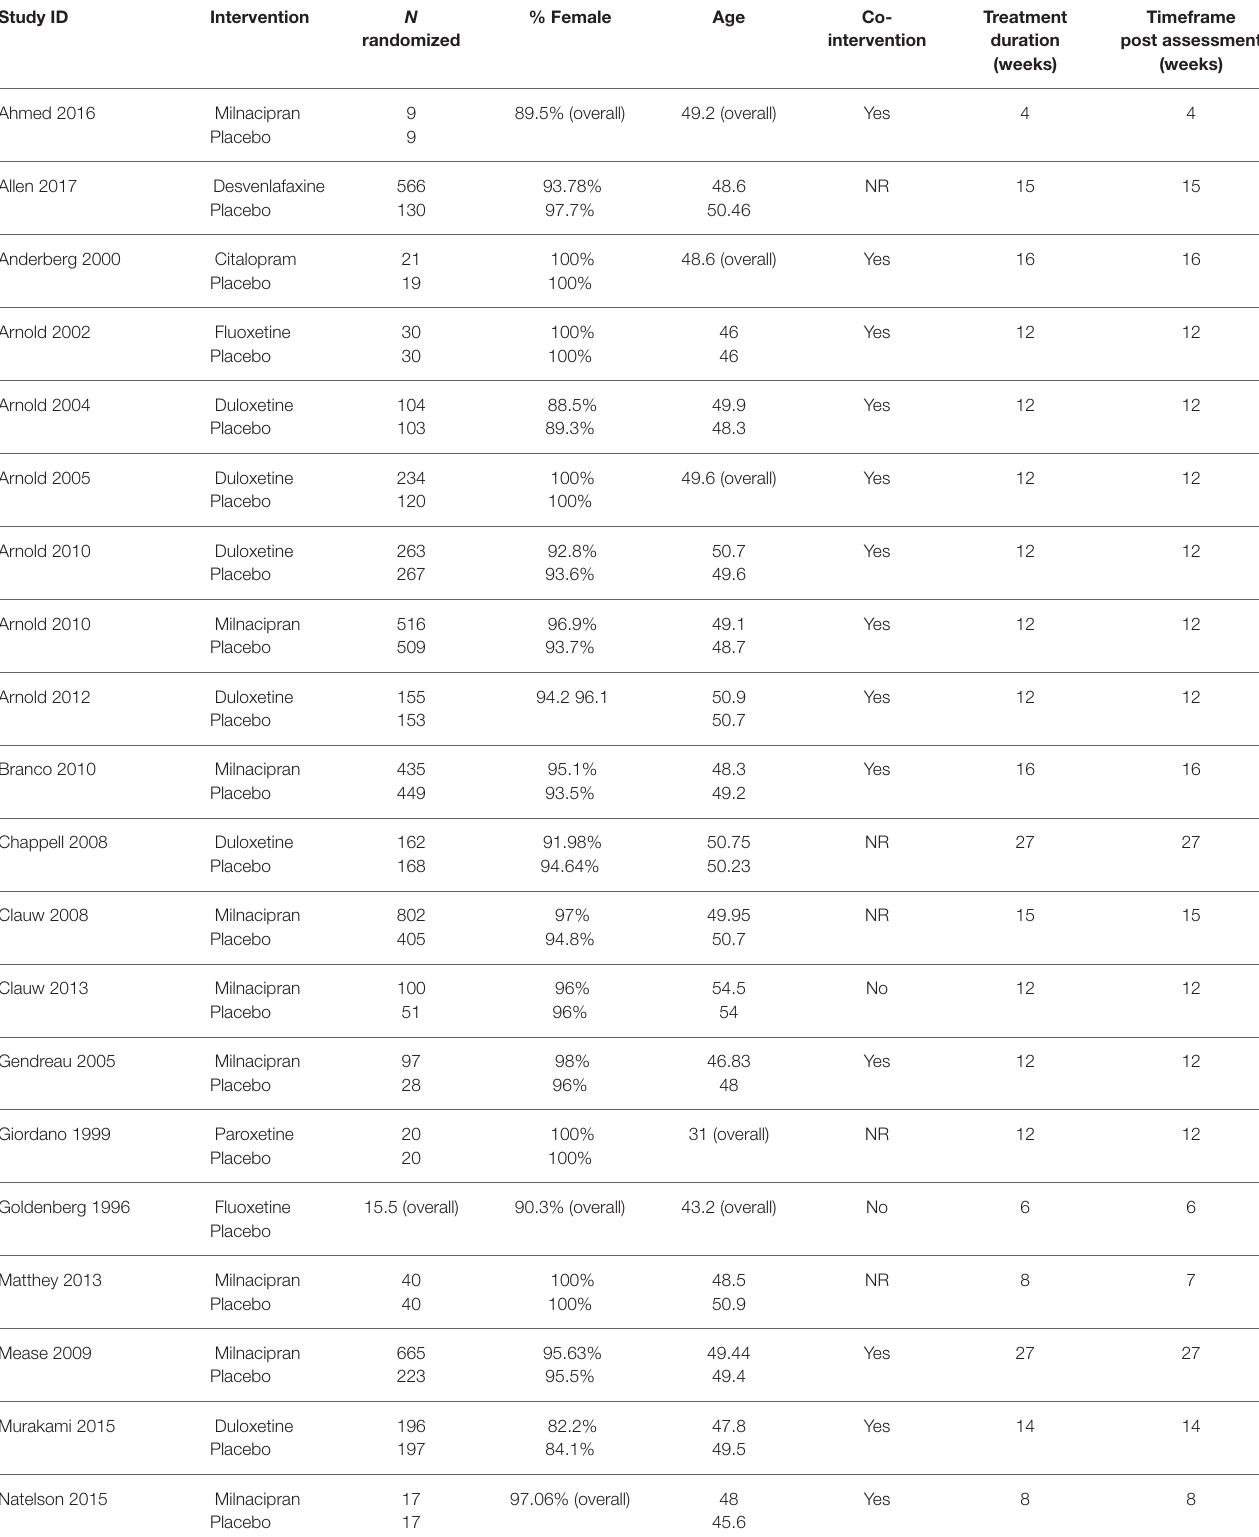
TABLE 1 | Characteristics of included